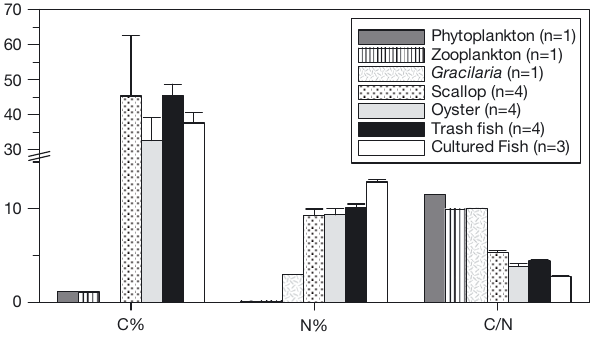
Fig. 4. The respective average values (±SD) of δ 13 C and δ 15 N were −21.1 ± 0.1‰ and 9.2 ± 0.4‰ for scallops, −21.1 ± 0.2‰ and 11.2 ± 0.3‰ for oysters, −20.9 ± 0.1‰ and 6.7‰ for Gracilaria , −19.0 ± 0.2‰ and −21.0 ± 0.6‰ for cultured fish, and 11.1 ± 0.3‰ and 9.6 ± 1.2‰ for trash fish.